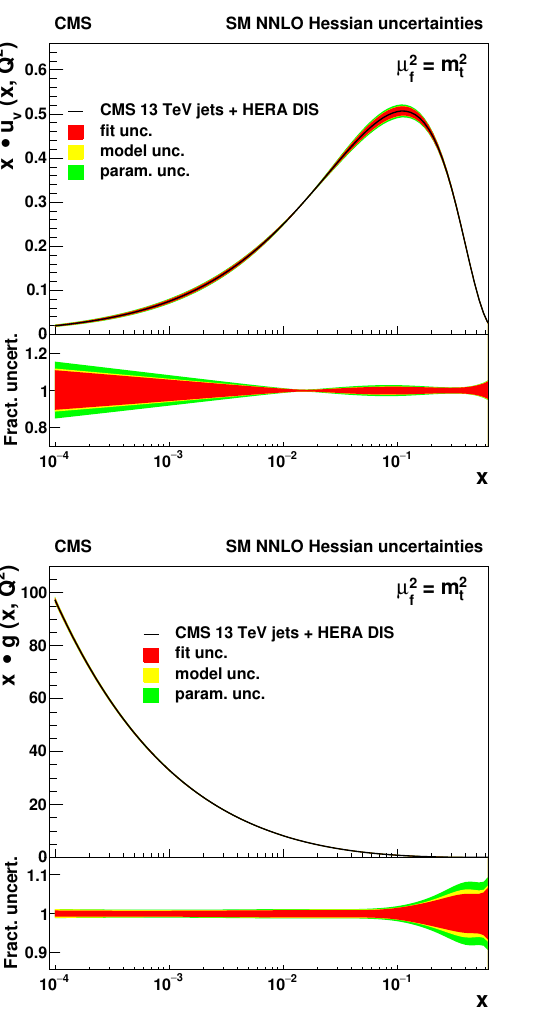
Figure 2 . The u -valence (upper left), d -valence (upper right), gluon (lower left), and sea quark (lower right) distributions shown as a function of x at the scale µ fit using HERA DIS data together with the CMS inclusive jet cross section at prediction for the inclusive jet cross section is obtained using NNLO interpolation grids. Contri- butions of the fit, model, and parametrisation uncertainties for each PDF are shown. In the lower panels, the relative uncertainty contributions are